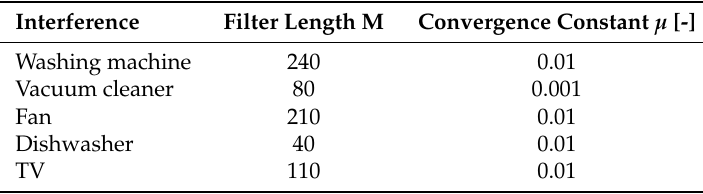
Table 4. Optimal parameter settings for the LMS algorithm, visualization of a “smart